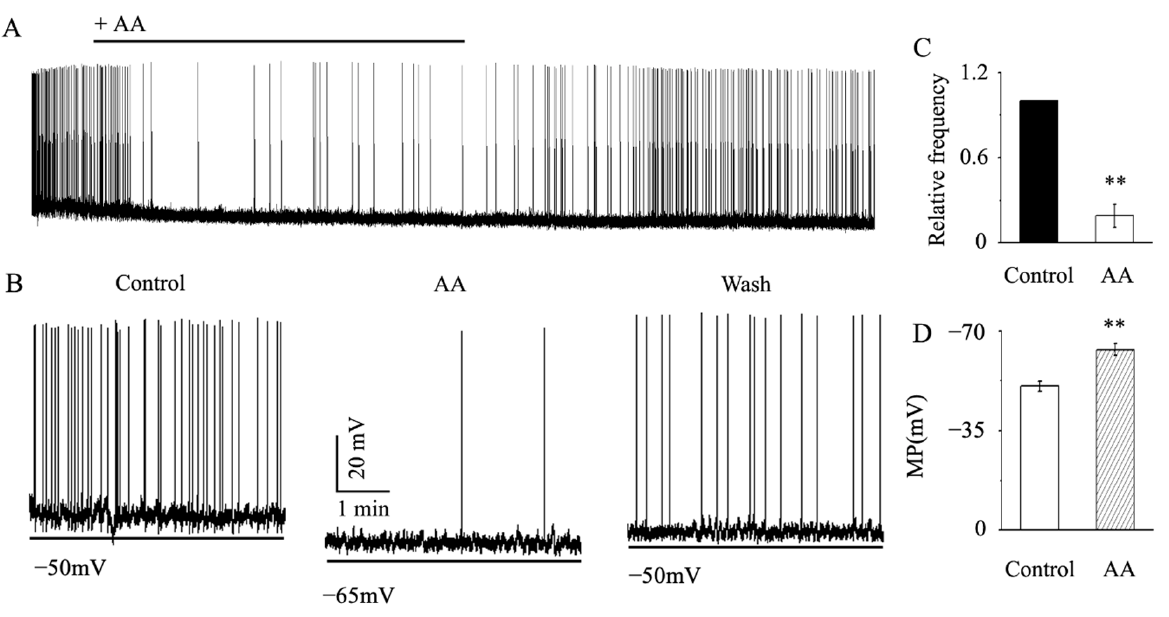
Figure 6. AA decreased glaucomatous RGC action potential frequency. ( A ) Representative record- ings showing that AA decreased glaucomatous RGC action potential frequency. ( B ) Typical large- scale traces demonstrating how 10 µ M AA affected the action potential and membrane potential of RGCs under control conditions (left), AA treatment (center) and recovery conditions (right). Horizontal scale bar, 1 min; vertical scale bar, 20 mV. ( C ) The frequency of action potentials under control conditions and following AA administration. ( D ) Membrane potential under control conditions and following AA administration. Student’s paired t test; ** p < 0.01 in comparison to the control condi- tions.